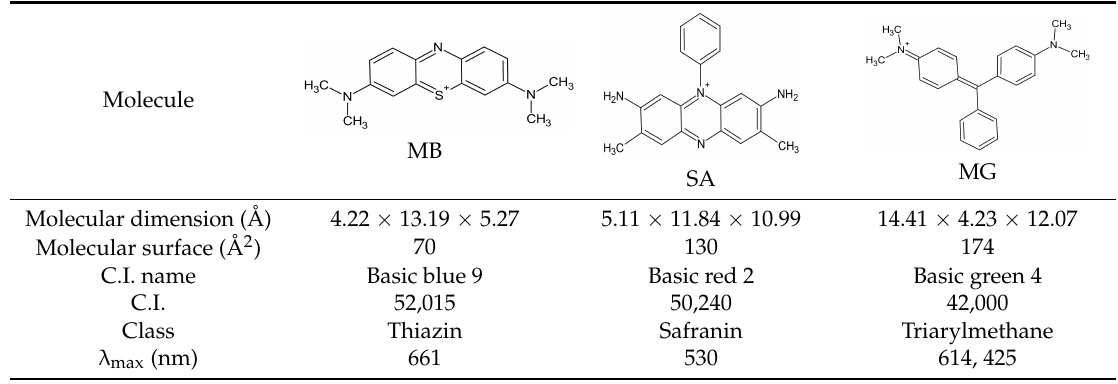
Table 2. Structures and relevant properties of the cationic dyes used in this work: methylene blue (MB), safranine (SA), and malachite green